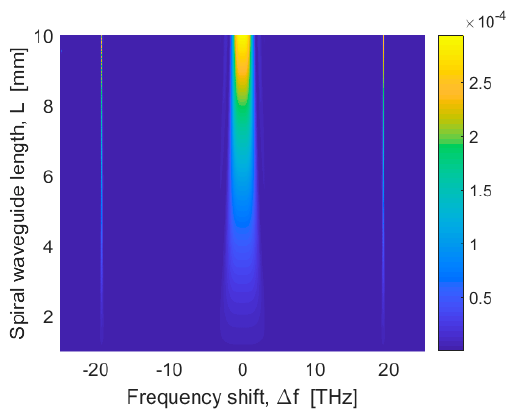
Figure 5. Photon pair generation rate as a function of the spiral waveguide length and frequency shift.